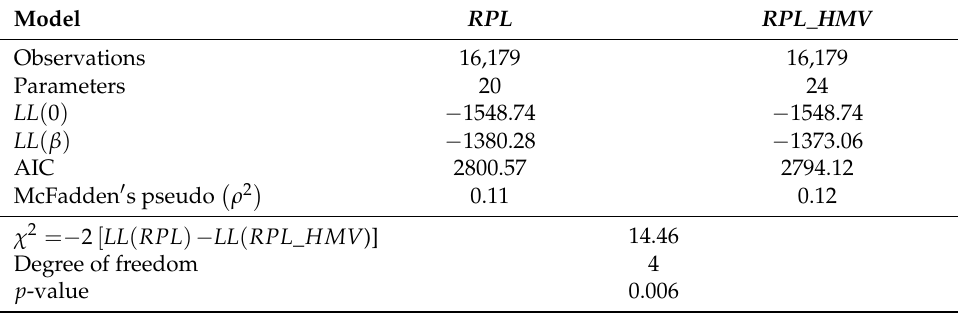
Table 2. Comparison of the estimated models’